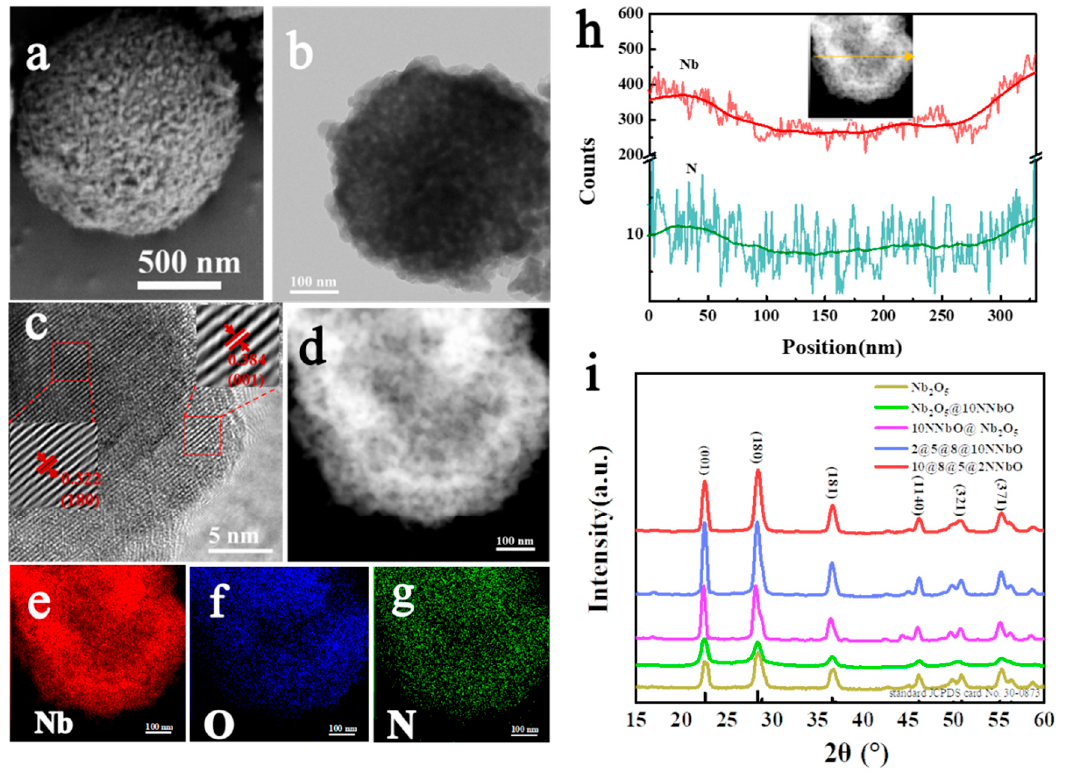
Figure 1. ( a ) SEM images, ( b ) TEM images, and ( c , d ) HRTEM image and ( e – g ) elemental mapping images of 10@8@5@2NNbO, respectively; ( h ) EDS line scan of the 10@8@5@2NNbO. (The arrow direction in the insert figure is the line sweep range) ( i ) XRD patterns of Nb 2 O 5 @10NNbO, 10NNbO@Nb 2 O 5 , 2@5@8@10NNbO, 10@8@5@2NNbO and Nb 2 O 5 .